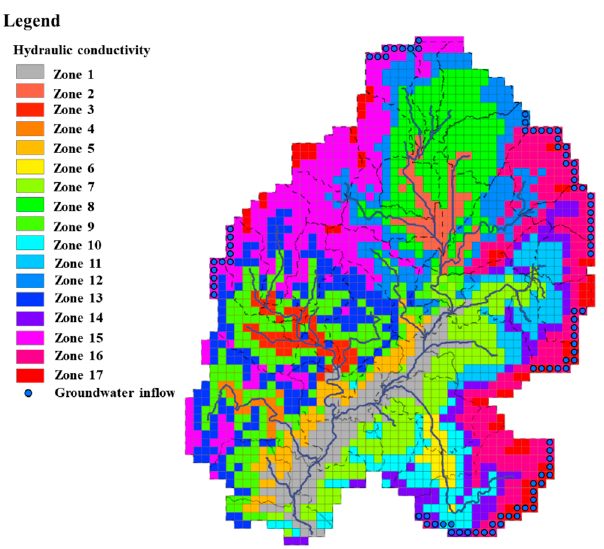
Figure 3. Grid map of the Miho catchment with key groundwater parameter zones.